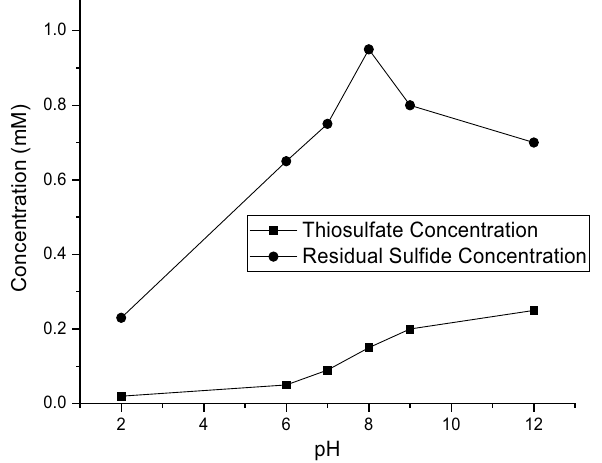
Figure 8. Concentration of produced thiosulfate and residual sulfide in demicrobized